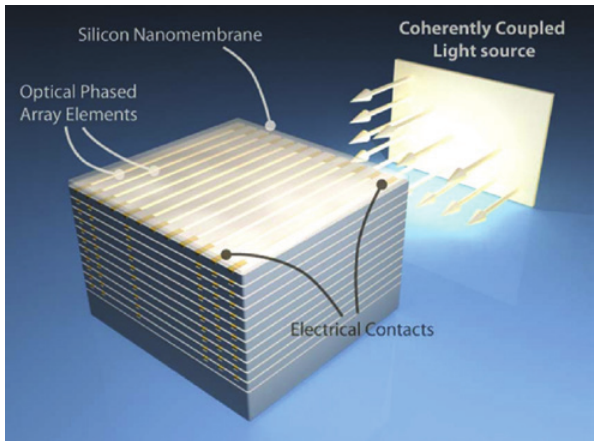
Figure 4: Envisioned stacking of 1D edge-emitting silicon photonic OPAs to realize a 2D emitter array, injection locked by a single master laser for coherent OPA emission. Reprinted with permission from Ref. [15]. Copyright 2010, American Vacuum